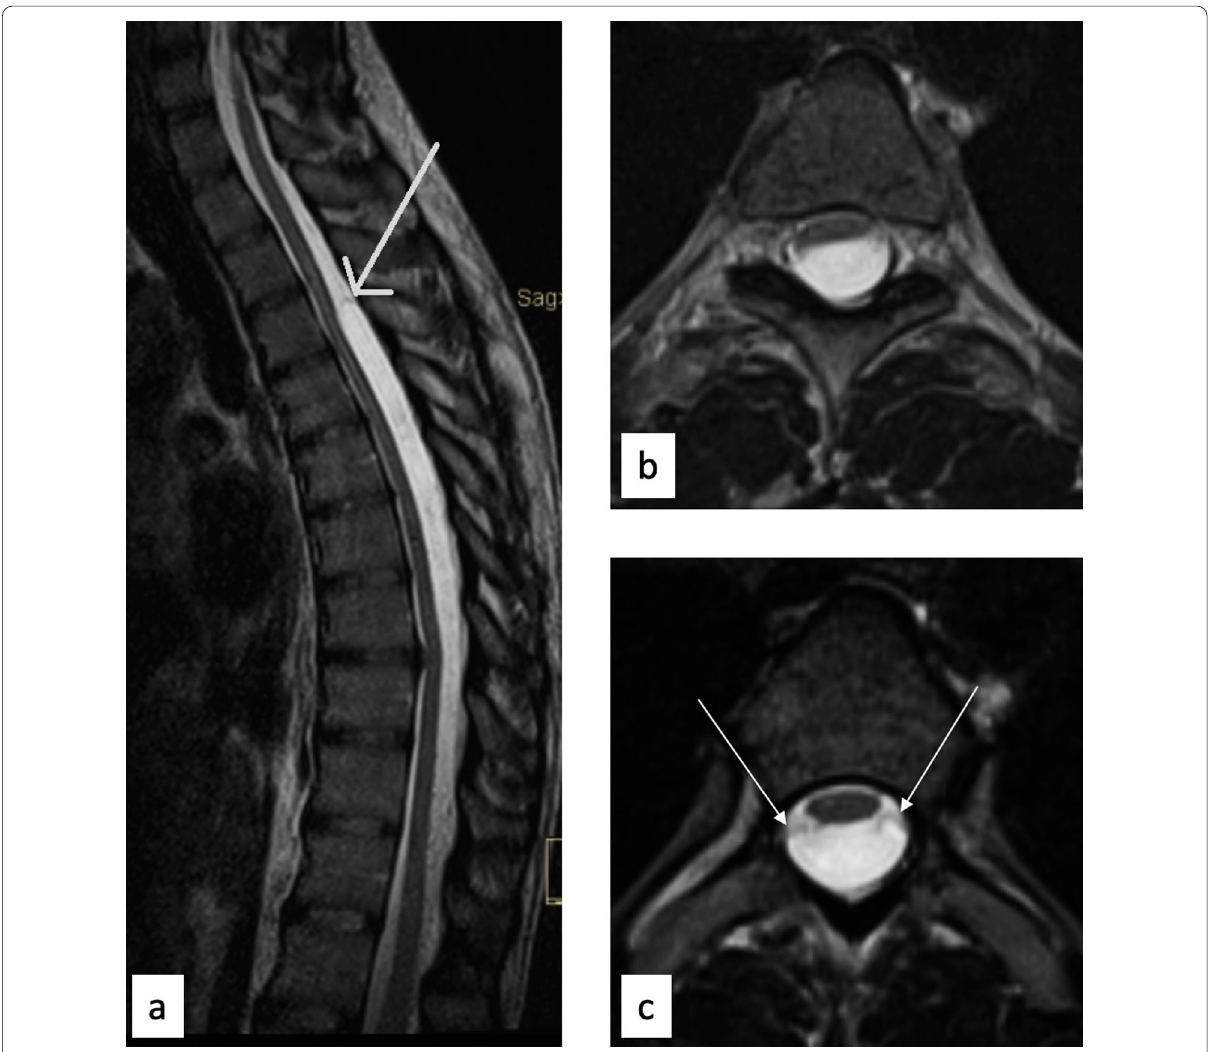
Fig. 4 MRI of the arachnoid cyst in dorsal spine T2W sagittal ( a ) and axial ( b , c ) sections demonstrating an increase in the posterior arachnoid space in mid and lower dorsal spine displacing and compressing the spinal cord anteriorly. A thin membrane is observed at the upper end (white arrow in a ) and anterior edge (white arrows in c